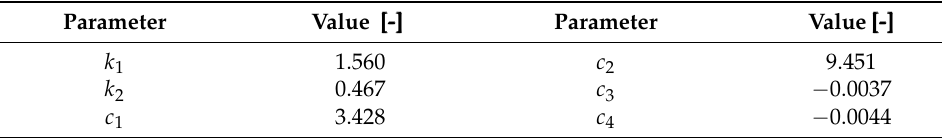
Table 1. Custom UAV parameters extracted from real-life